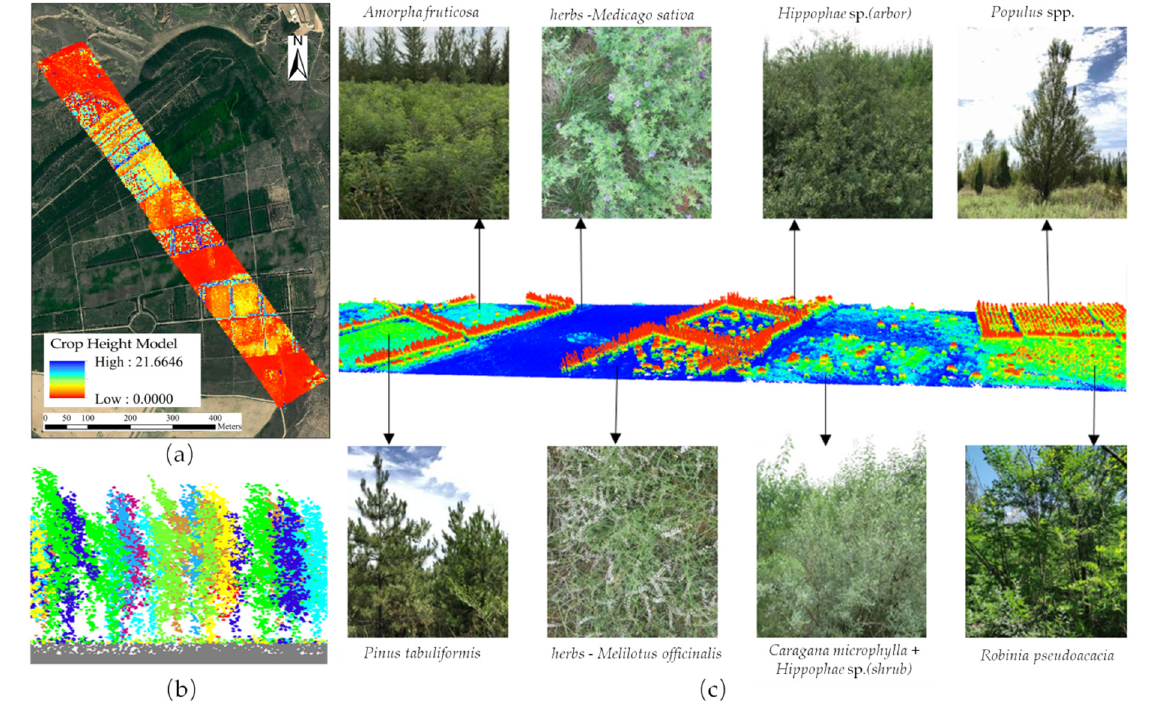
Figure 16. ( a ) Canopy heights of trees, shrubs, herbs, and bare land in study area; ( b ) cross-sectional view of single tree segmentation result; ( c ) three-dimensional models of different vegetation species compositions.